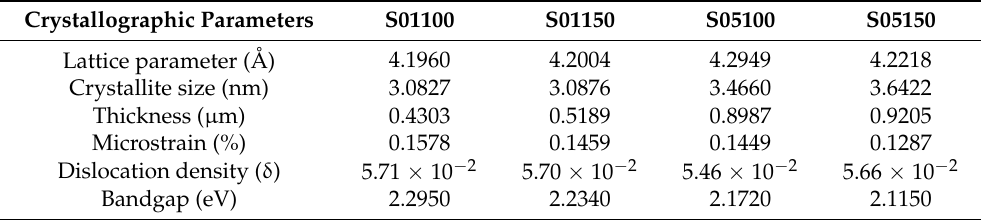
Table 1. The crystallographic parameters of